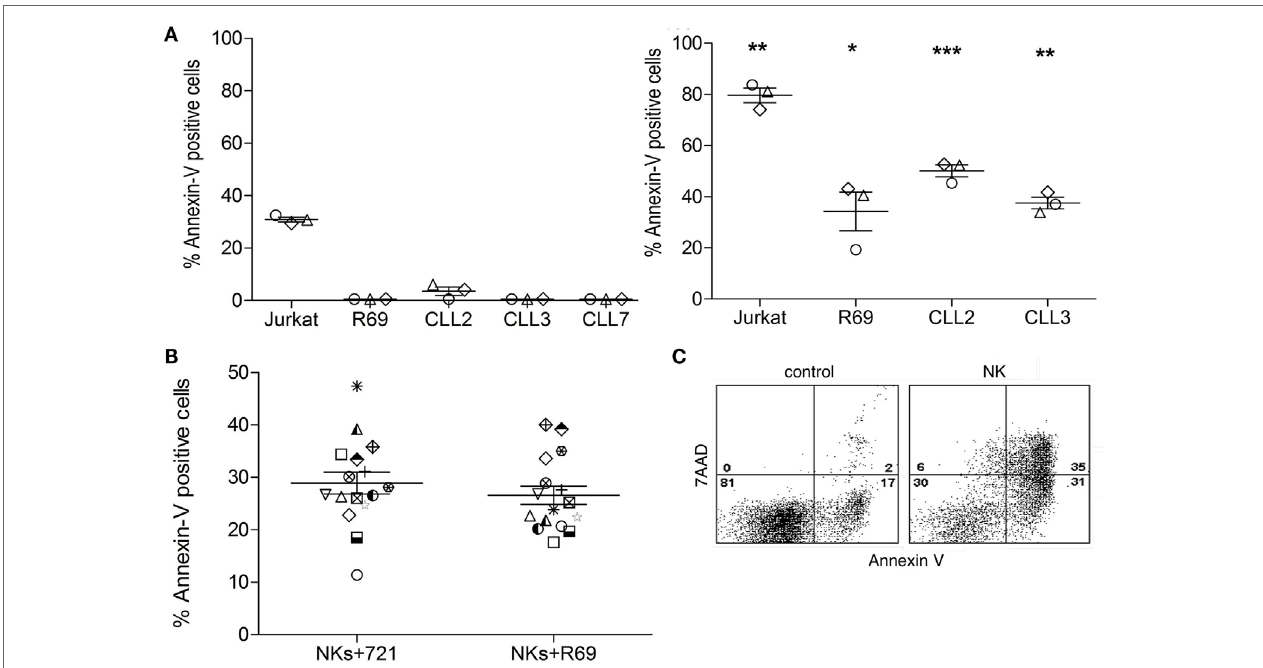
FigUre 1 | allogeneic nK cells require activation to kill B-cll cells . (a) Jurkat and R69 cells or cells from B-CLL patients were incubated with naïve (left) or R69-LCL activated (right) NK cells (MACS enriched, > 90% CD56 + CD3 − cells; CTGreen labeled) for 4 h at 9:1 effector:target ratio as described in Section “Materials and Methods.” Subsequently, PS traslocation (annexin V DY634) and membrane permeabilization (7AAD uptake) were analyzed by flow cytometry in the cell population negative for CTGreen. (B) Cells from B-CLL were incubated with R69- or 721-LCL-activated NK cells (MACS enriched, > 90% CD56 + CD3 − cells; CTGreen labeled) for 4 h at 9:1 effector:target ratio as described in Section “Materials and Methods.” Subsequently, PS traslocation (annexin V DY634) and membrane permeabilization (7AAD uptake) were analyzed by flow cytometry in the cell population negative for CTGreen. Data in the graphics are represented as the mean ± SEM from three independent NK cell donors (a) or from 14 independent B-CLL patients (B) . Annexin V + cells represent the % of AnnexinV + 7AAD − plus AnnexinV + 7AAD + cells. Statistical analysis was performed by comparing the means of naive versus activated NK cells within each group using 2-way ANOVA with Tukey HSD post hoc test; ns, not significant, * p < 0.05, ** p < 0.01, *** p < 0.001. (c) Representative dot plot of Annexin V/7AAD staining in a B-CLL sample incubated in medium alone (control) or together with NK cells (NK). Numbers correspond to the % of cells in each